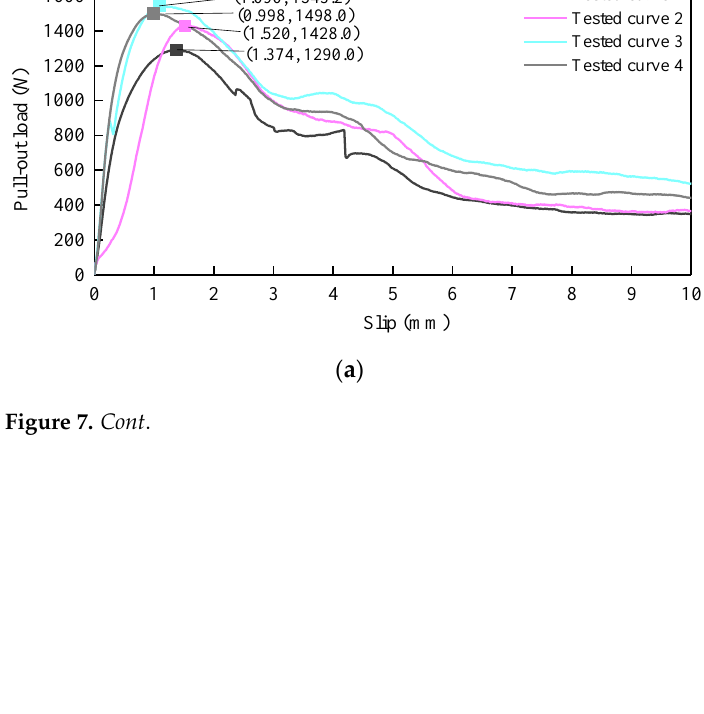
Figure 6. The procedure of determining the characteristic pull-out load-slip curve. Take the pull-out test of HF6 as example. Four test curves are presented in Figure 7a with their peak loads and corresponding slips. As the load difference was within 15% of the average, all four test curves are valid. The average peak load is 1439.8 N with a corre- sponding slip of 1.246 mm. As presented in Figure 7b, the normalized curve of each curve is obtained with load and corresponding slip divided by the peak load P max and corre- sponding slip s p , respectively. The slip ratio s / s p , corresponding to the same value of load ratio P / P max , is averaged to obtain the average normalized ascending segment of the valid curve. The load ratio P / P max , corresponding to the same slip ratio s / s p , is averaged to obtain the average normalized descending segment of the curve. Then, the average normaliza- tion curve is obtained. At last, as shown in Figure 7c, the characteristic pull-out load-slip curve of HF6 is obtained by multiplying the average normalized curve with the average of the peak load and corresponding slip, respectively.